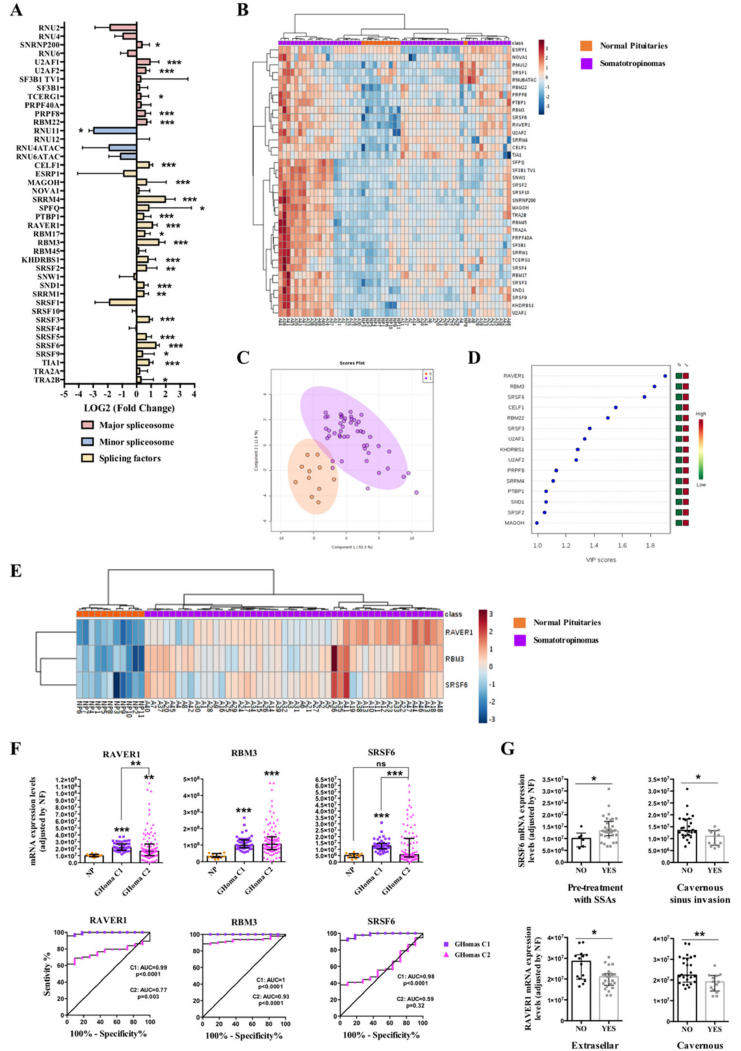
Figure 2. Somatotropinomas (GHomas). ( A ) Individual Fold-Change of each splicing-regulatory element expression levels in GHomas compared to normal pituitary glands (NPs). ( B ) Heatmap of the mRNA expression levels of all splicing-regulatory elements measured in the qPCR array in GHomas (n = 48; green color) compared to NPs ( n = 11; red color). ( C ) Principal Components Analysis (PCA) of the mRNA expression levels of the splicing-regulatory elements analyzed in the same set of samples. ( D ) Variable Importance in Projection (VIP) Scores top-feature of Partial Least Squares Discriminant Analysis (PLS-DA). ( E ) Heatmap of the splicing-regulatory elements with higher VIP score in the same set of samples. ( F ) mRNA expression levels of splicing-regulatory elements with higher VIP score in GHomas from cohorts 1 (C1; n = 48) and 2 (C2; n = 83) compared to NPs ( n = 11) and Receiver Operating Characteristic (ROC) curves analyses showing the accuracy of the selected splicing-regulatory elements to discriminate between both cohorts of GHomas and NPs. ( G ) Correlations between SRSF6 and RAVER1 expression and clinical parameters. Data represent median ± interquartile range of absolute expression levels (copy number) of each transcript adjusted by a normalization factor. Asterisks (* p < 0.05, ** p < 0.01, *** p < 0.001) indicate statistically significant di ff erences between